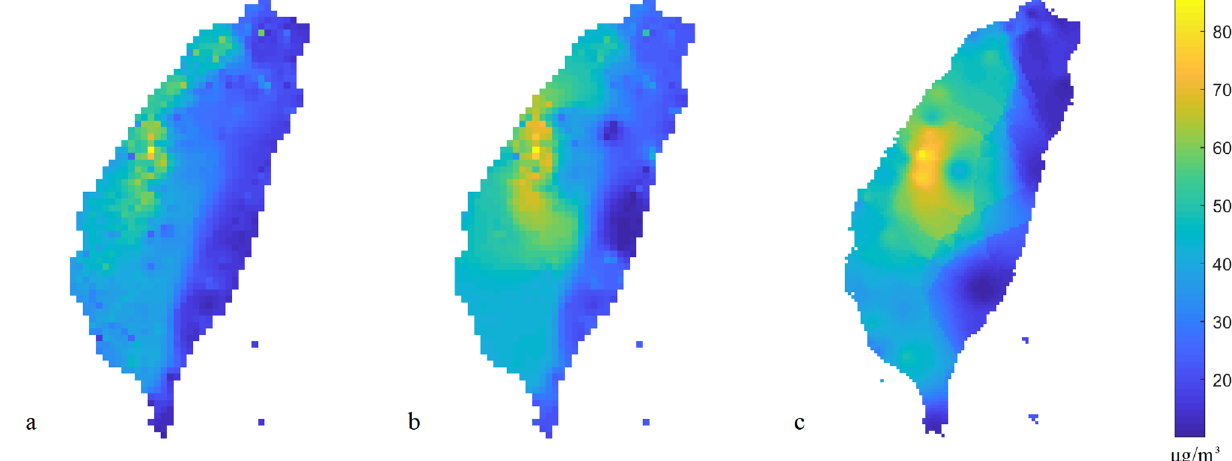
Figure 9. PM 2.5 mapping based on calibrated low-cost sensors from ( a ) nonspatial calibration model, ( b ) spatial calibration model, and PM 2.5 mapping based on ( c ) regulatory station data only. The plots were created in MATLAB_R2018B (https ://www.mathw orks.com/produ cts/matla